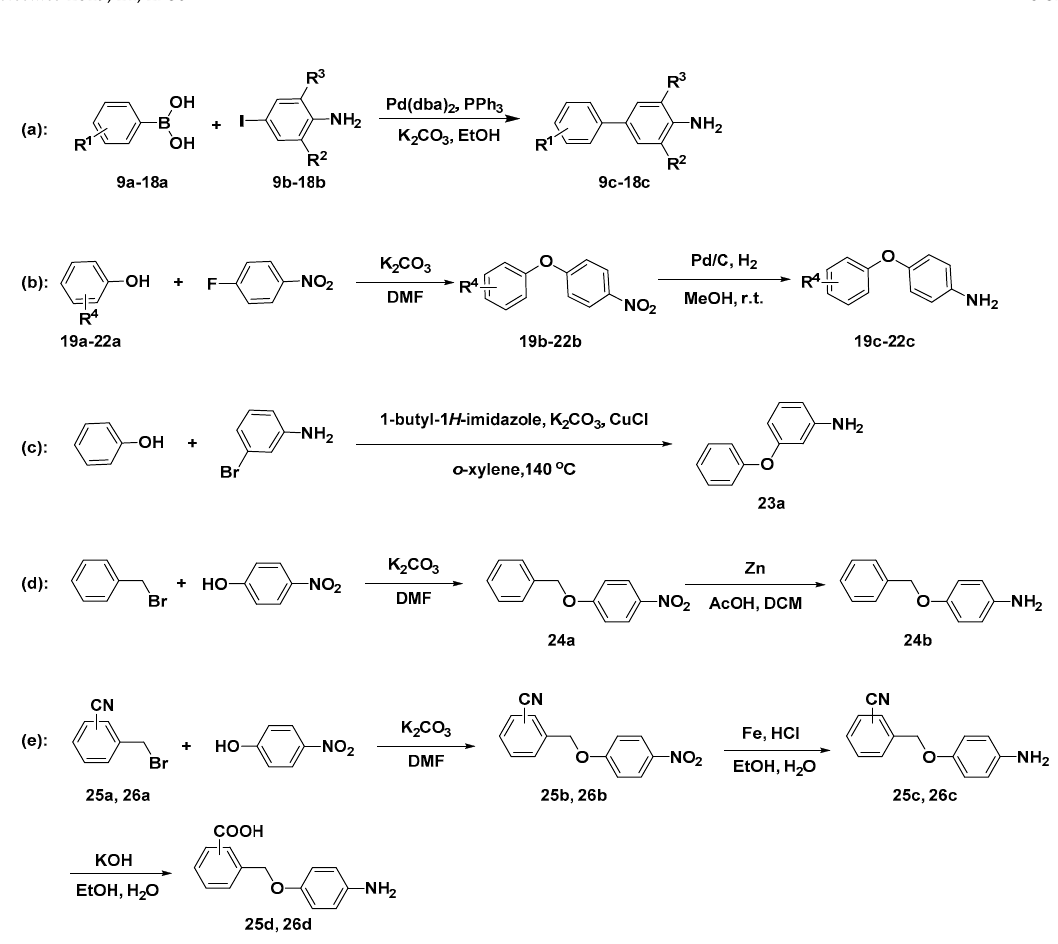
Scheme 1. Synthesis of key intermediates of compounds 9 – 26